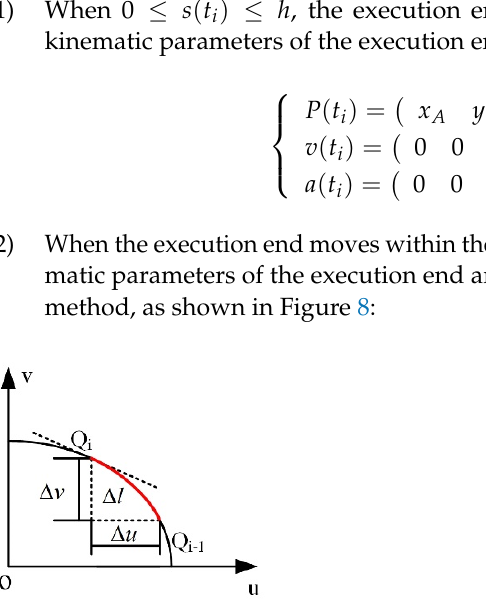
Figure 8. Schematic diagram of the Láme curve arc differential.